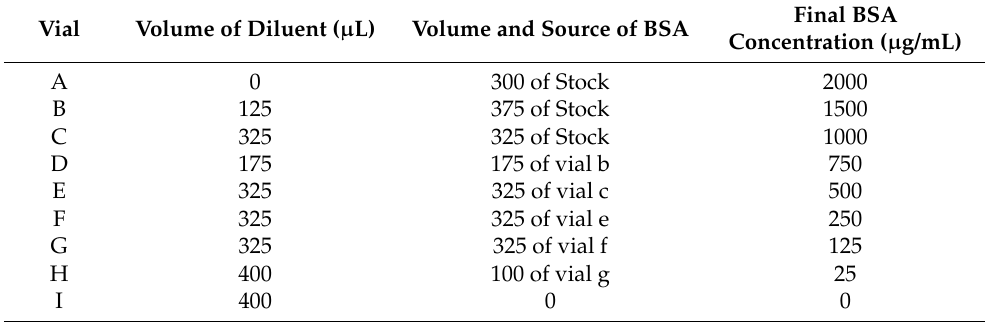
Table 1. Dilution scheme for test tube protocol with a working range of 20–2000 µ g/mL.